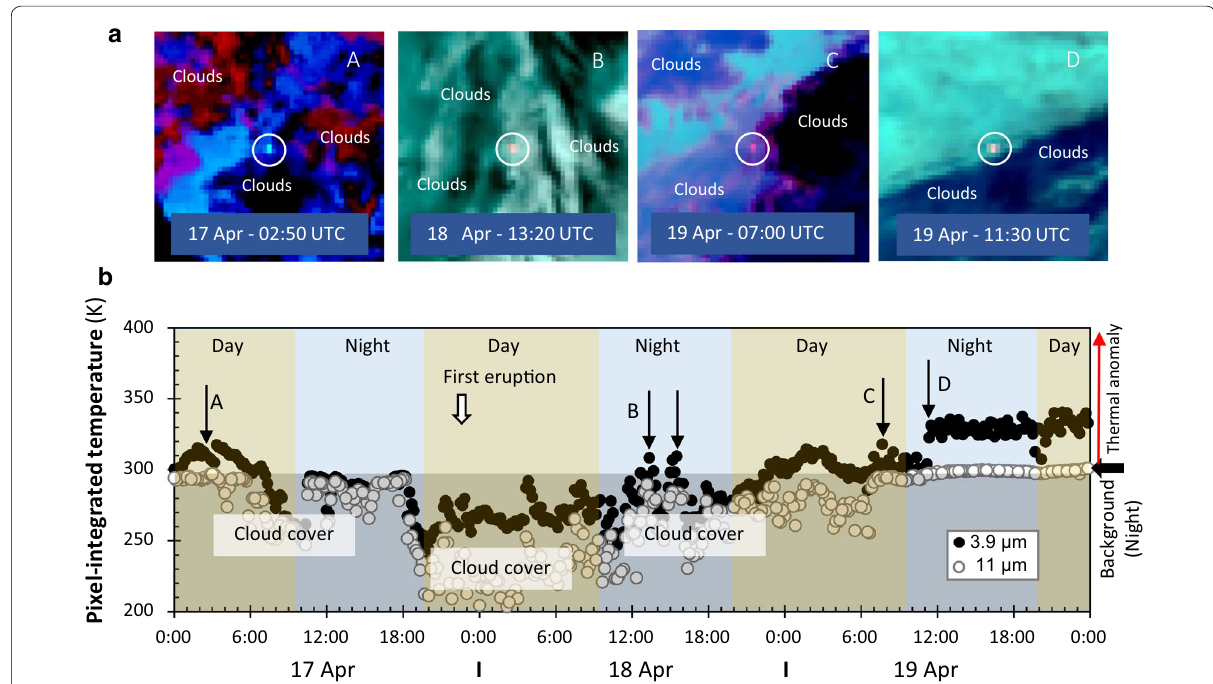
Fig. 2 a Himawari-8 AHI images acquired around the start of the activity. A–D correlate with these labels in b , and also the image collection times are marked by them in b . b Time-series variation of maximum pixel-integrated temperature at 3.9 µm (T3.9Mx: closed circles) and 11 µm (T11Mx: open circles) between 17 and 19 April 2017. Arrows labeled A–D indicate the times at which the images in a were